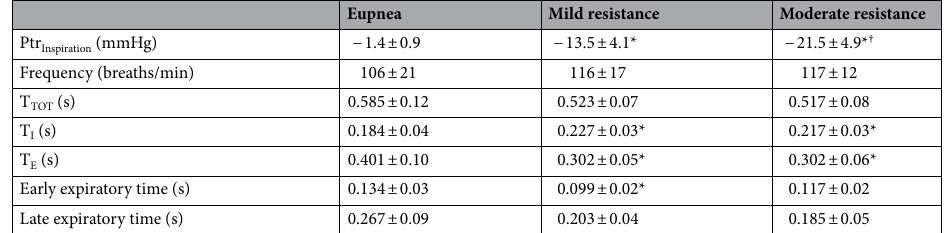
Table 1. Respiratory loading increases the work of breathing. Inspiratory tracheal pressure (Ptr Inspiration ), frequency, total time of one respiratory cycle (T TOT ), inspiratory time (T I ), expiratory time (T E ), early expiratory, and late expiratory time during eupnea, mild, and moderate resistance loading. Data are presented as mean ± SD. * p < 0.05 versus eupnea, † p < 0.05 mild versus moderate resistance load. All data were analyzed using a within-subject one-way repeated measures ANOVA with Sidak’s correction, n = 7.